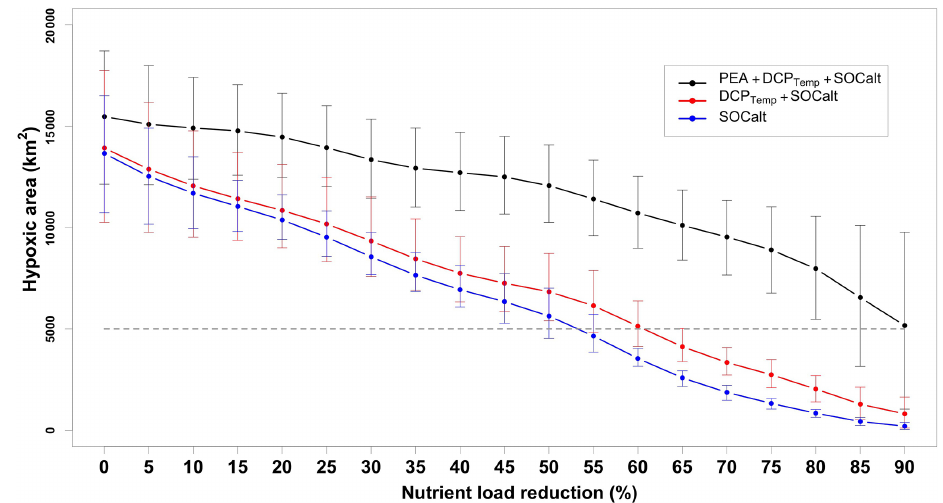
Figure 9. Mean for 2015–2020 (except 2016) predicted HA in scenarios of different nutrient load reduction strategies given different sets of predictors considered. Predictions by the ensemble model are conducted individually for the shelf-wide cruise periods in different sum- mers and averaged from 2015–2020. Horizontal bars indicate ranges of 95% PIs. Grey dashed lines represent the goal of 5000km 2 set by the Mississippi River/Gulf of Mexico Hypoxia Task Force. Note here nutrient reduction percentages refer to mid-June nutrient loads in corresponding